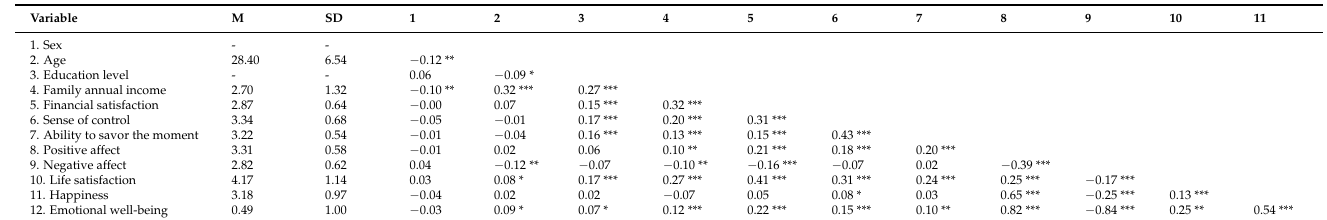
Table 4. Description and correlation analysis in study 2 ( N =